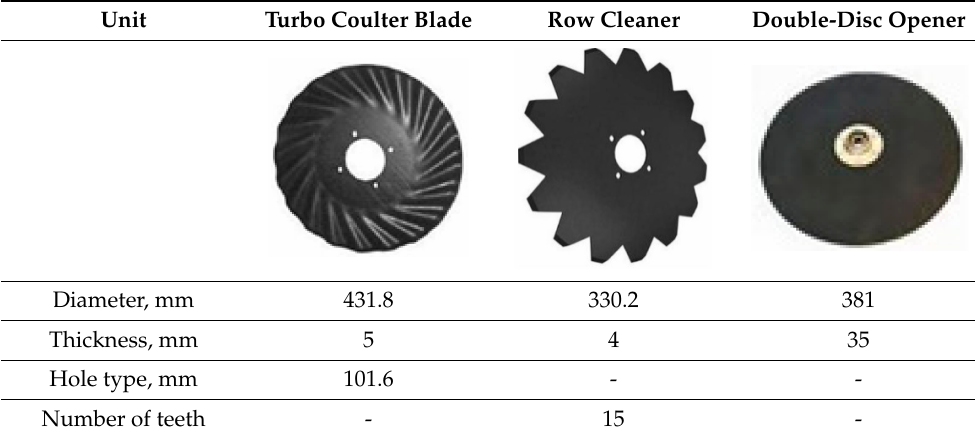
Table 4. Characteristics of the turbo coulter blade, row cleaner, and double-disc opener used in the